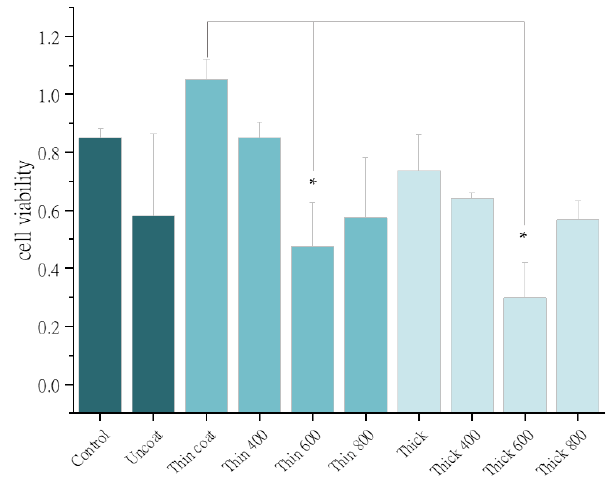
Figure 8. MTT analysis of uncoated titanium surface, coated Co 30 Cr 20 Ni 20 Mo 20 , and heat treated surfaces. The significant difference between thin coat and samples heat treated at 600 °C is marked with hysteric.